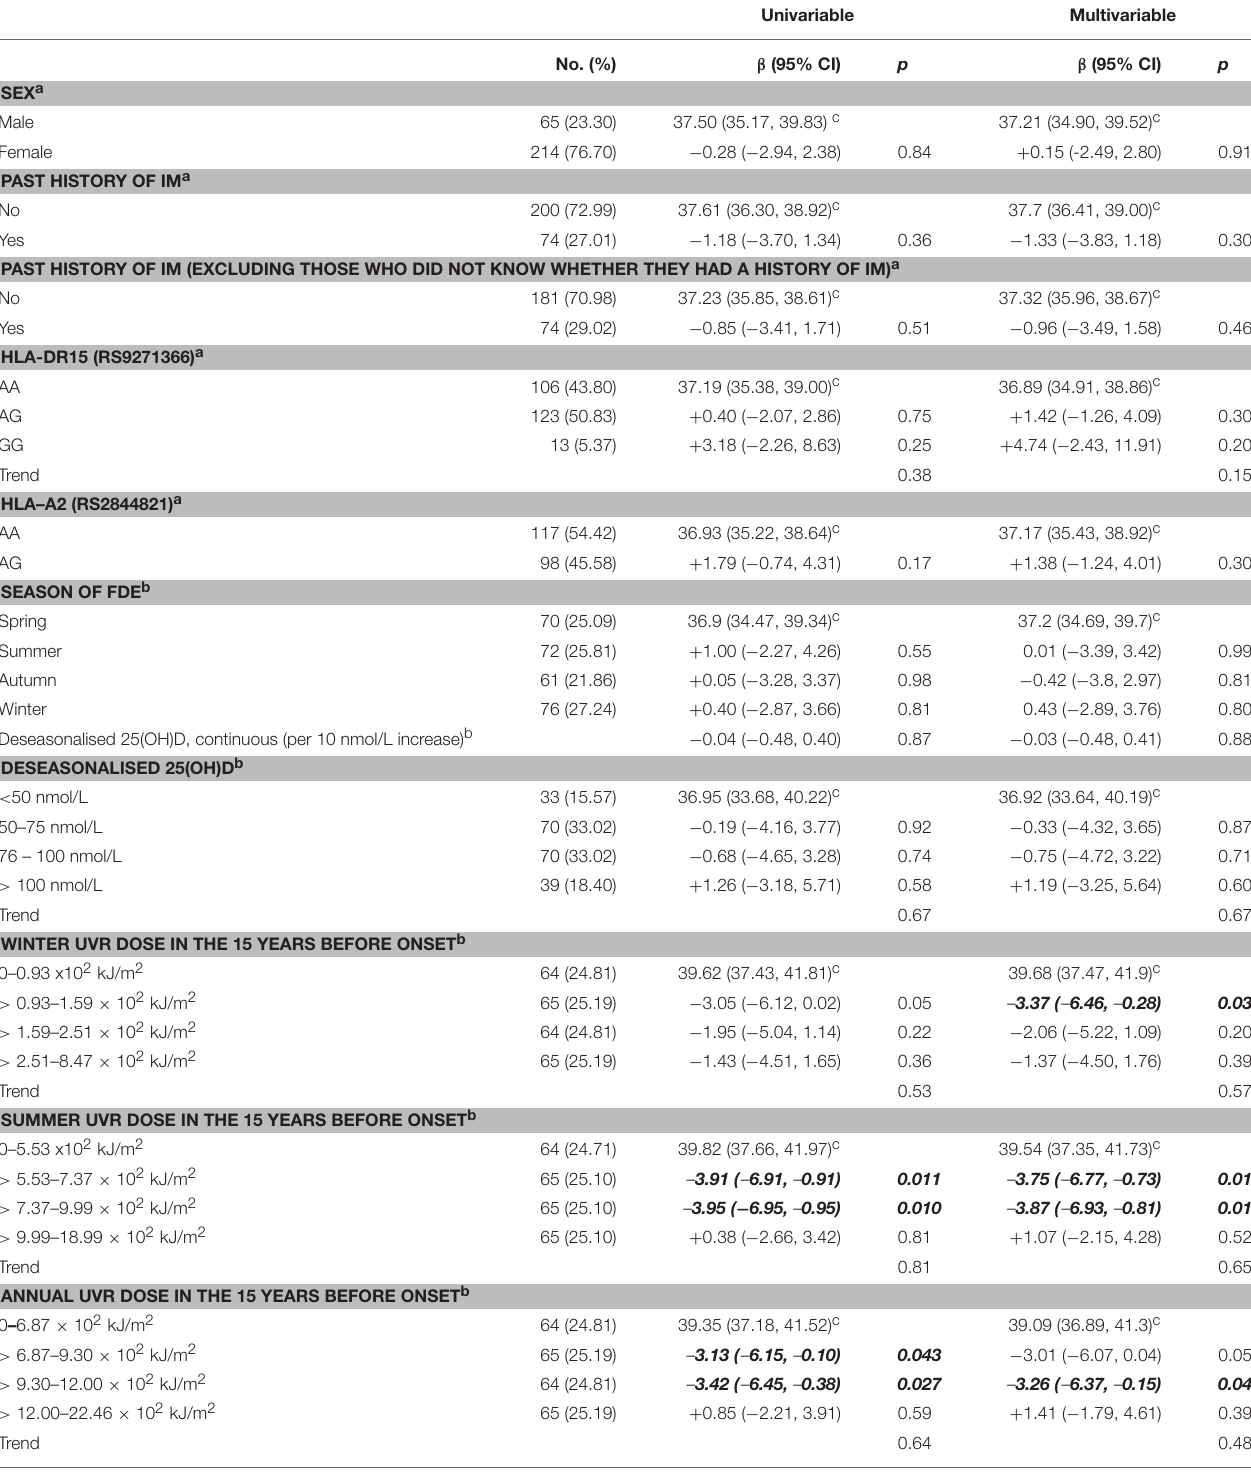
TABLE 1 | Associations between sex, IM history, HLA-DR15 genotype, HLA-A2 genotype, 25(OH)D, UVR exposure and age of symptom onset.